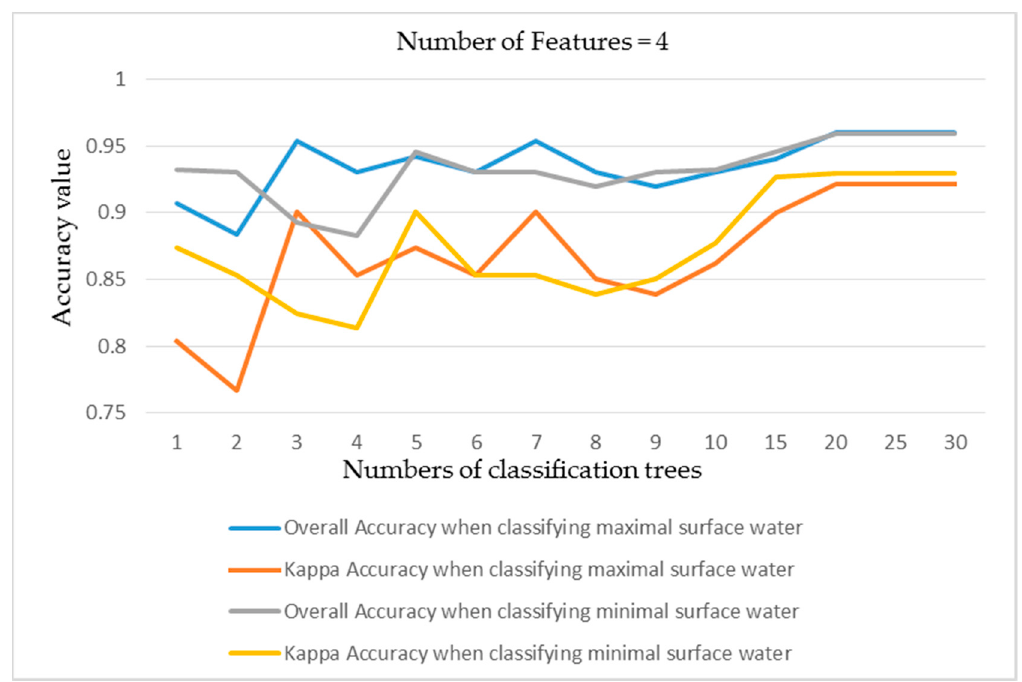
Figure 6. Impacts of different numbers of trees in the Random Forest (RF) based on the overall accuracy and Kappa accuracy.